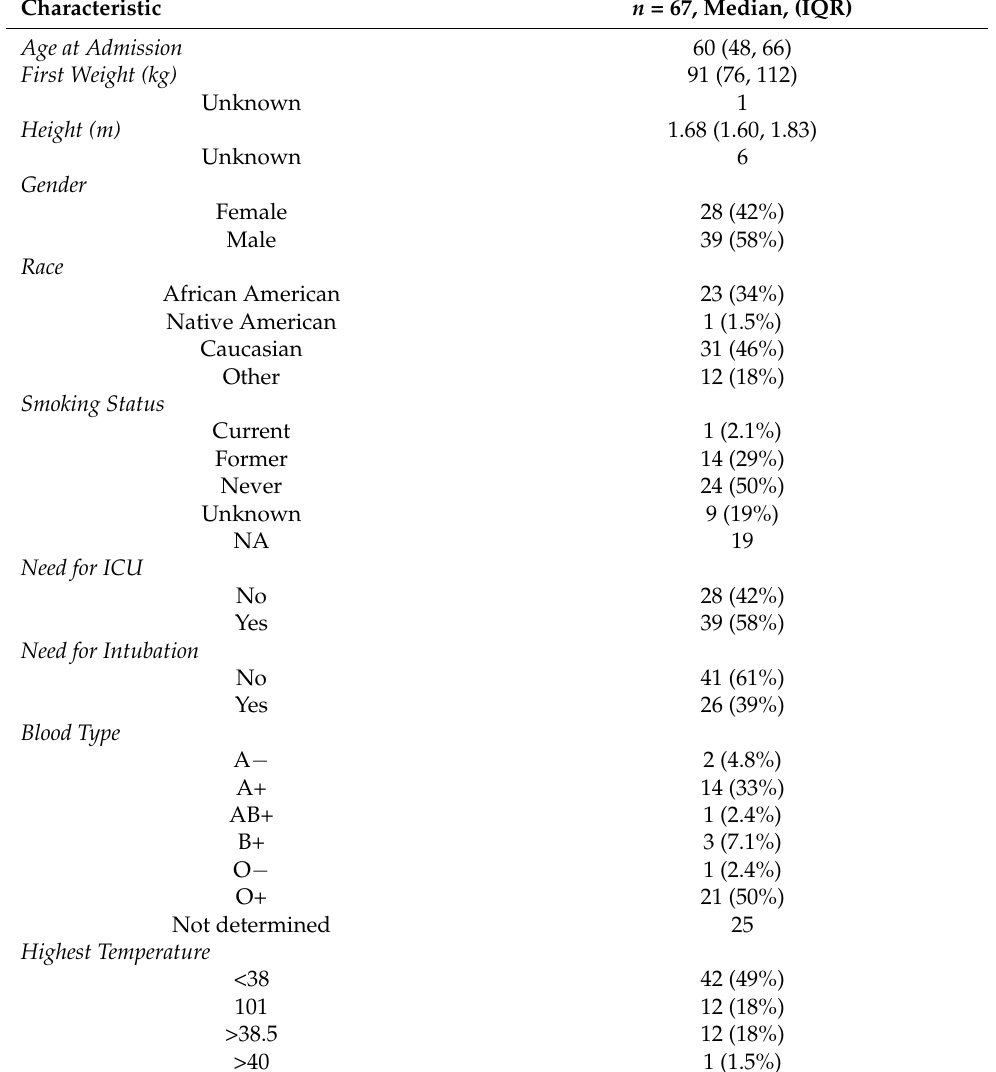
Table 1. Patient Demographic and Clinical Characteristics (IQR: interquartile